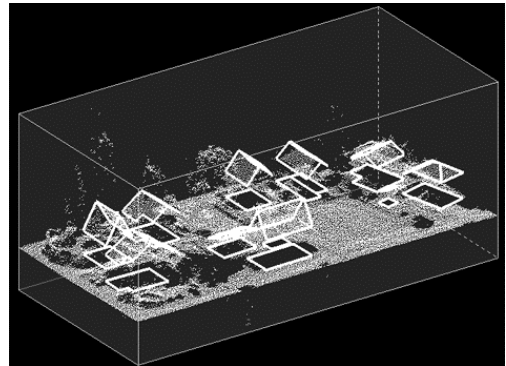
Figure 6. Profile data of DSM result